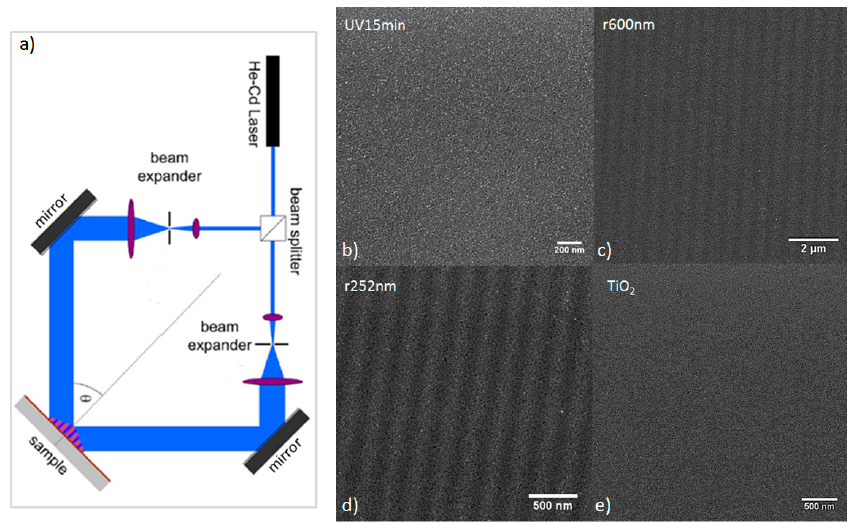
Figure 2. ( a ) Sketch of the holographic bench. Scanning electron microscopy (SEM) images of samples UV15min ( b ), r600nm ( c ), r252nm ( d ) and TiO 2 ( e ).